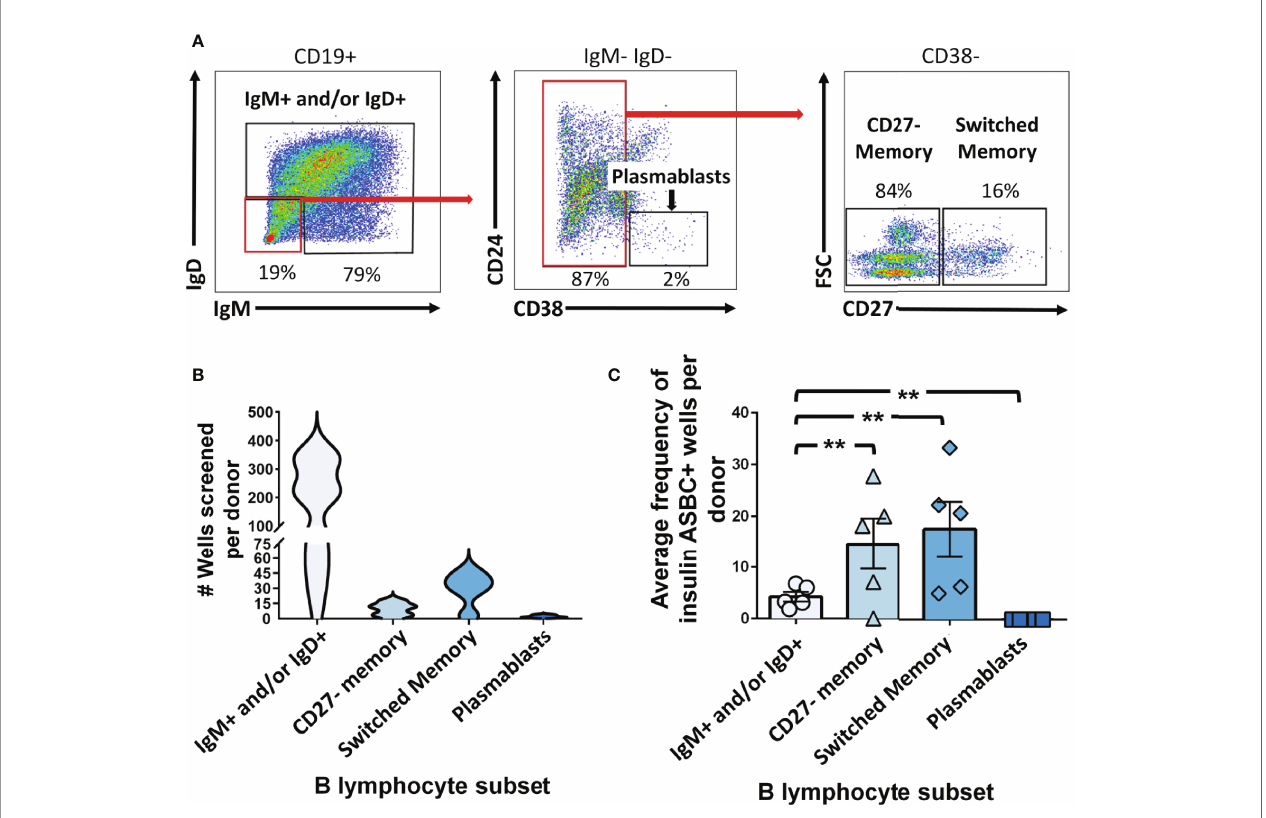
FIGURE 5 | Insulin-binding ASBCs are identi fi ed within speci fi c B cell subsets. (A) Representative plots show fl ow cytometry identi fi cation of the indicated B cell subsets (gated on CD19 + live singlet lymphocytes). Subsets were de fi ned as follows: IgM + and/or IgD + , CD27 - memory (IgD + IgM + CD27 - CD38 - ), and CD27 + switched memory (IgD - IgM - CD27 + CD38 - ). (B) Data distribution and density of wells screened per donor are expressed as a violin plot per subset. (C) PBMCs were isolated from n=5 participants at high risk for type 1 diabetes [positive for ≥ two islet autoantibodies, one of which was insulin autoantibody (IAA)]; fl ow cytometry- puri fi ed B cell subsets (identi fi ed as in Figure 1 ) were plated in 384-well plates at ~300 cells/well and stimulated as in Methods for 1 wk. ELISA was used to measure anti-insulin antibody in culture supernatants to identify wells containing insulin-binding ASBCs (positive wells de fi ned as O.D. 370nm ≥ 0.85 which was one standard deviation above the mean and which displayed reduced insulin antibody binding when parallel supernatants were incubated with 100-fold excess soluble insulin competitor). Errors bars shown are SEM per subset. Each data point represents the average % insulin-binding ASBCs identi fi ed per donor for each B cell subset. **p < 0.01, Mann-Whitney U